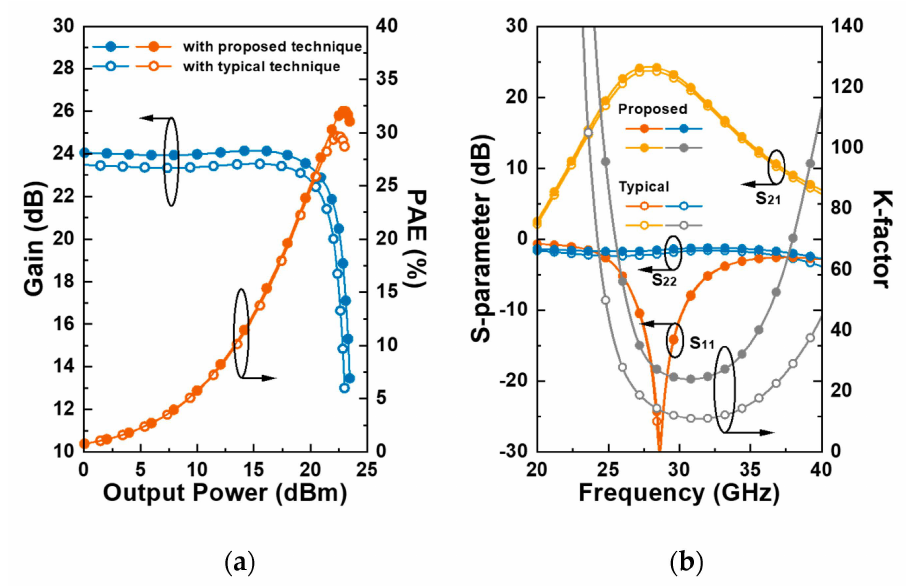
Figure 12. Simulation results: ( a ) gain and PAE and ( b ) S-parameters.